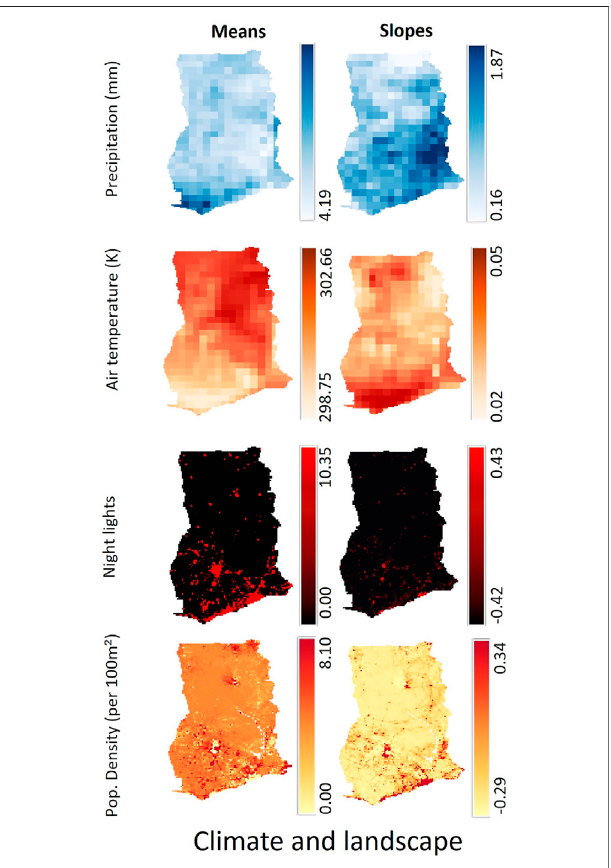
FIGURE 5 | Spatial variations in means and trends of precipitation, temperature, night lights, and population density. Data sources are presented in Table 1